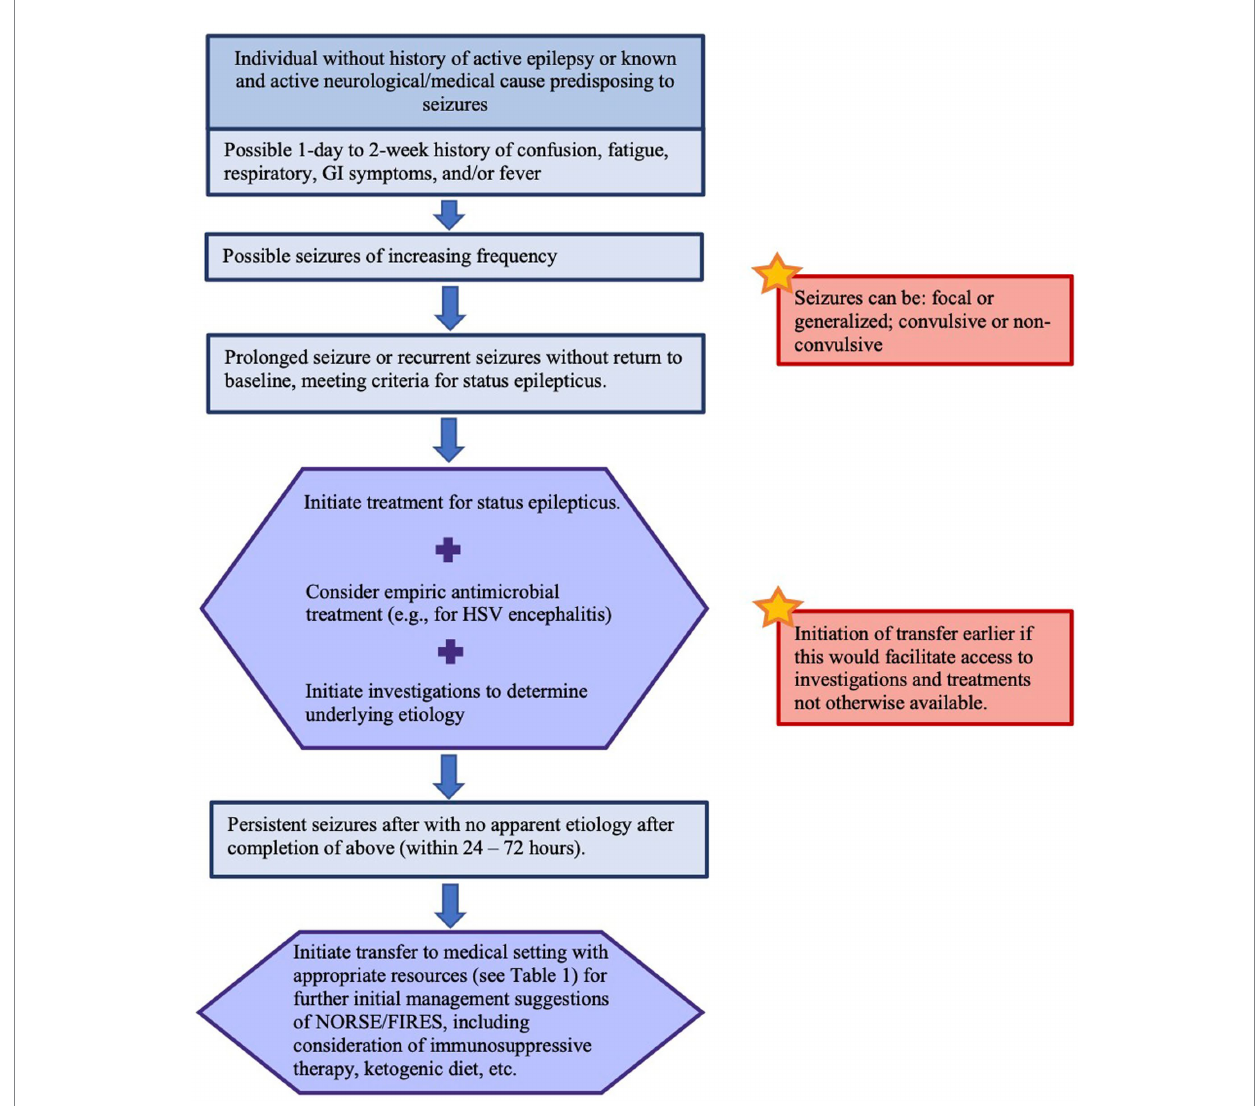
FIGURE 1 Proposed algorithm for recognition of NORSE/FIRES and transfer to a medical setting with appropriate resources. Please refer to reference (13) for details on recommended management of status epilepticus. Please refer to references (17, 20) for detailed recommendations on investigations and management of